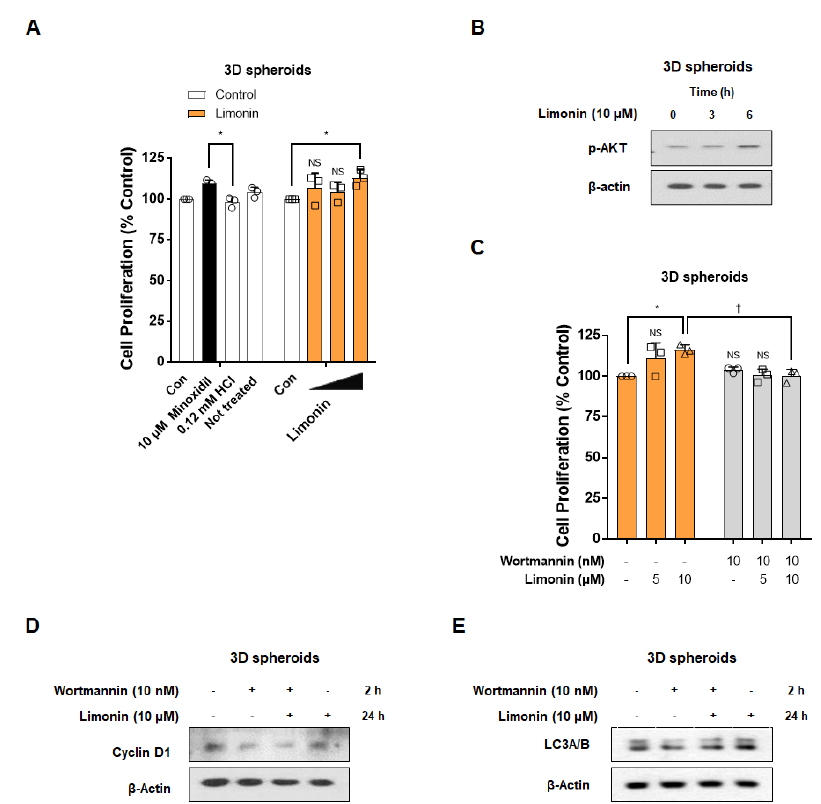
Figure 5. Limonin induces cell proliferation through alterations in the autophagy pathway by activation of the PI3K/AKT pathway in three-dimensional (3D) spheroids. ( A ) Effects of limonin on the proliferation of 3D spheroids. ( B ) Representative images of Western blots for phospho(Ser473)- AKT in 3D spheroids treated with limonin for 0–6 h. ( C ) Changes in the proliferation of 3D spheroids after treatment with limonin for 3 days with or withoutwortmannin. ( D ) Representative images of Western blots for p27 in 3D spheroids treated with limonin for 24 h with or without wortmannin. ( E ) Representative images of Western blots for LC3A/B in 3D spheroids treated with limonin for 24 h with or without wortmannin. * p < 0.05 vs. vehicle-treated control. † p < 0.05 vs. limonin alone. Con, vehicle-treated control; 0.12 mM HCl, vehicle for minoxidil; NS, not